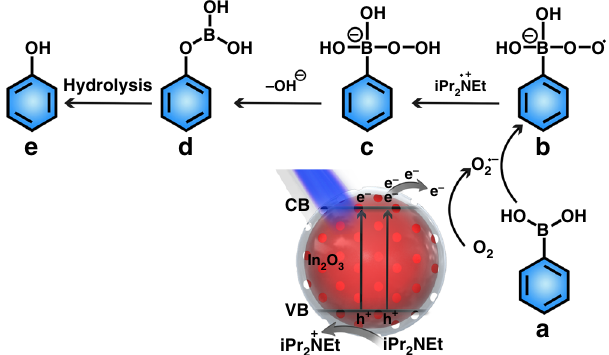
Fig. 7 Schematic illustration exhibiting the proposed reaction mechanism (a – e) for OHAA using N,S-C/In 2 O 3 DHR as the Based on above studies, a possible photocatalytic mechanism of OHAA over N,S-C/In 2 O 3 DHR was proposed (Fig. 7). Firstly, the photogenerated carriers are excited in N,S-C/In 2 O 3 DHR under blue LED irradiation. Then, the photogenerated electrons are transferred to the N,S-codoped carbon layer, and the photo- generated holes still stay on the In 2 O 3 nanoparticles. Secondly, the adsorbed O 2 molecule is reduced by separated electrons, resulting in the formations of ∙ O 2 − . The DIEA molecule (iPr 2 Net) can capture the separated holes to form iPr 2 N + Et. Thirdly, the obtained ∙ O 2 − would react with arylboronic acid molecule (a) to generate intermediate (b). The intermediate (b) then abstracts a hydrogen atom from iPr 2 N + Et to form intermediate (c), which is further rearranged with the loss of a – OH − ion to form (d). The intermediate (d) is subsequently hydrolyzed to afford the fi nal phenol product (e).